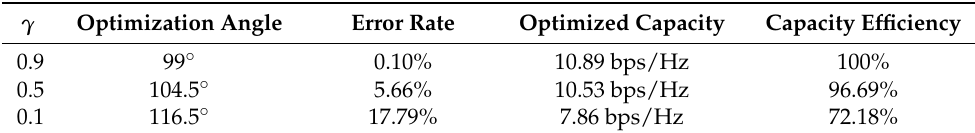
Table 7. Optimized values for antenna downtilt and channel capacity with different discount rates at D = 150 m.